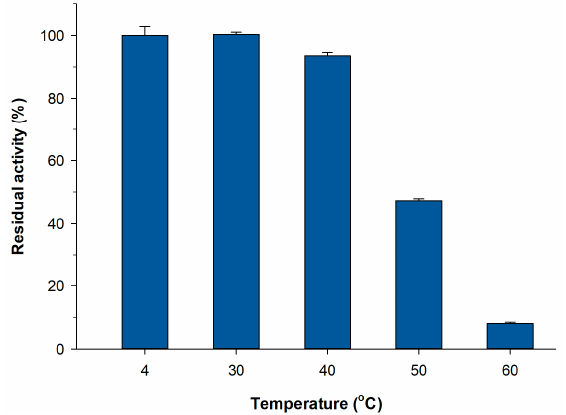
Figure 5. Thermostability of immobilized pXd-INV in PVA. Incubation conditions: 100 mM sodium acetate buffer (pH 5.0), 24 h.